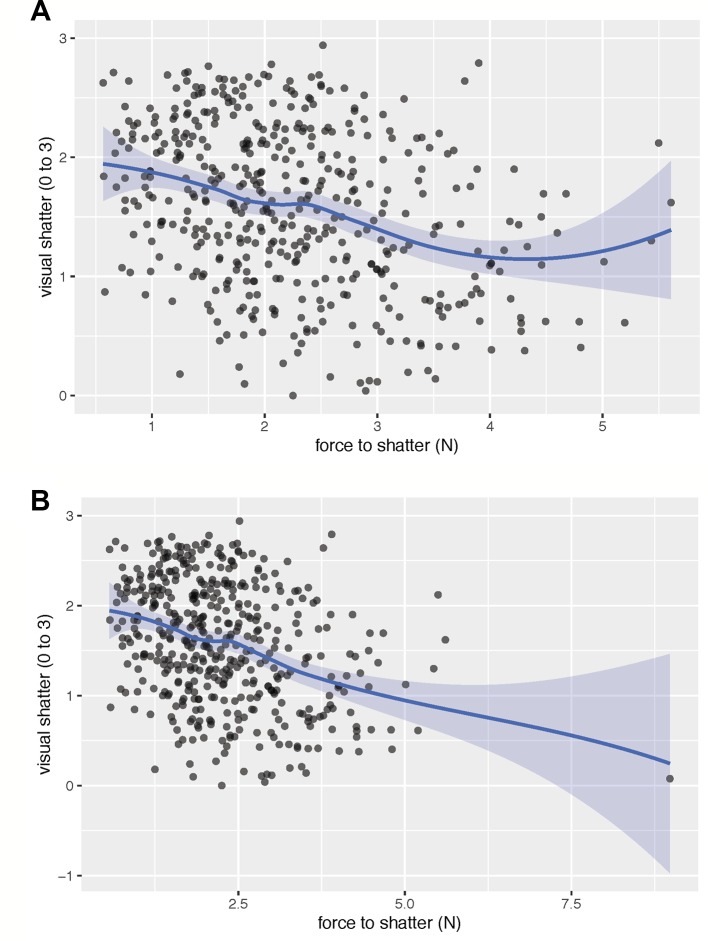
The fitted spline shows the relationship between visual rating of dehiscence and the force required to cause dehiscence, excluding (A) and including (B) an extreme outlier for force to dehiscence. When excluding the outlier, there was a moderate linear relationship (r = −0.33) between visual dehiscence and force to dehiscence. The linear relationship broke down at low levels of visual dehiscence and high force required to cause pod dehiscence. Both traits may be necessary to identify lines most resistant to dehiscence. Visual dehiscence was scored on a 0–3 scale, with “0” indicating a pod fully intact pod (no openings along sutures), “1” indicating one suture was partially opened (one side of pod), “2” indicating two sutures were partially opened (both sides of pod), and “3” indicating that the pod had opened fully or partially.